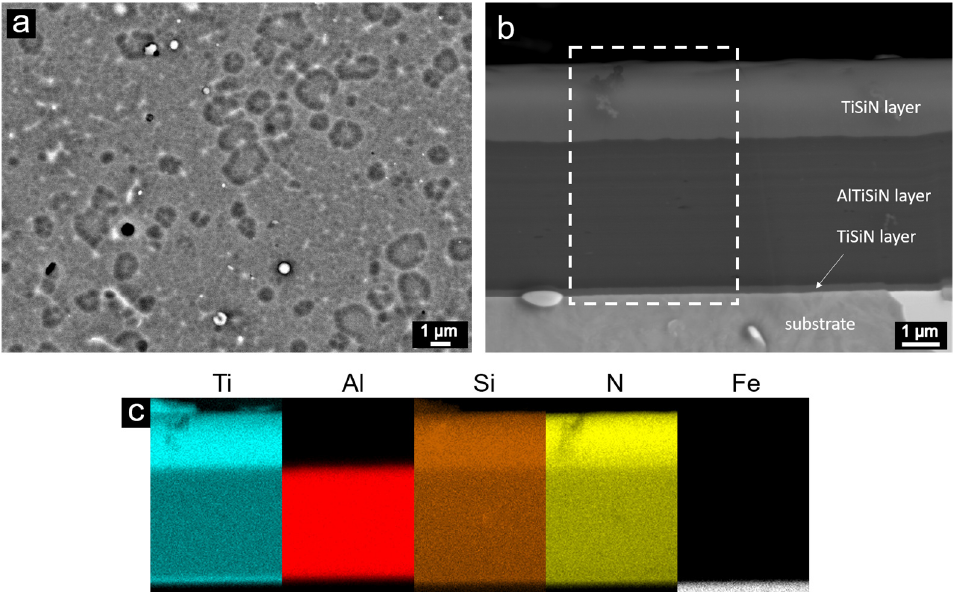
Figure 1. Surface ( a ), cross-section (the white dashed line rectangle marks the area where the EDX mapping was performed) ( b ) and elemental maps of cross-section ( c ) of the coating in as-deposited state, as documented by SEM/EDX. Cyan, red, brown, yellow and white colors correspond to Ti, Al, Si, N and Fe, respectively.